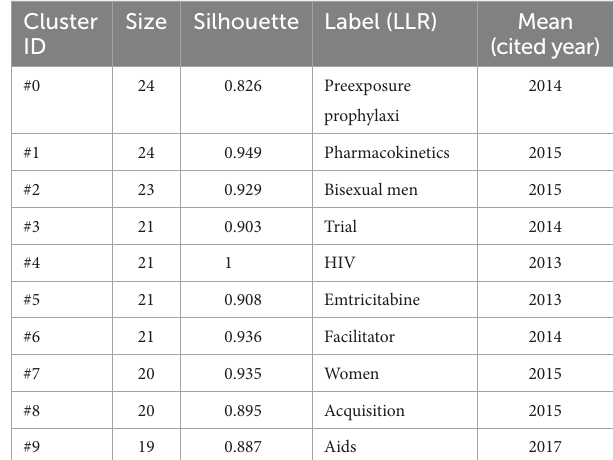
TABLE 5 Keyword cluster